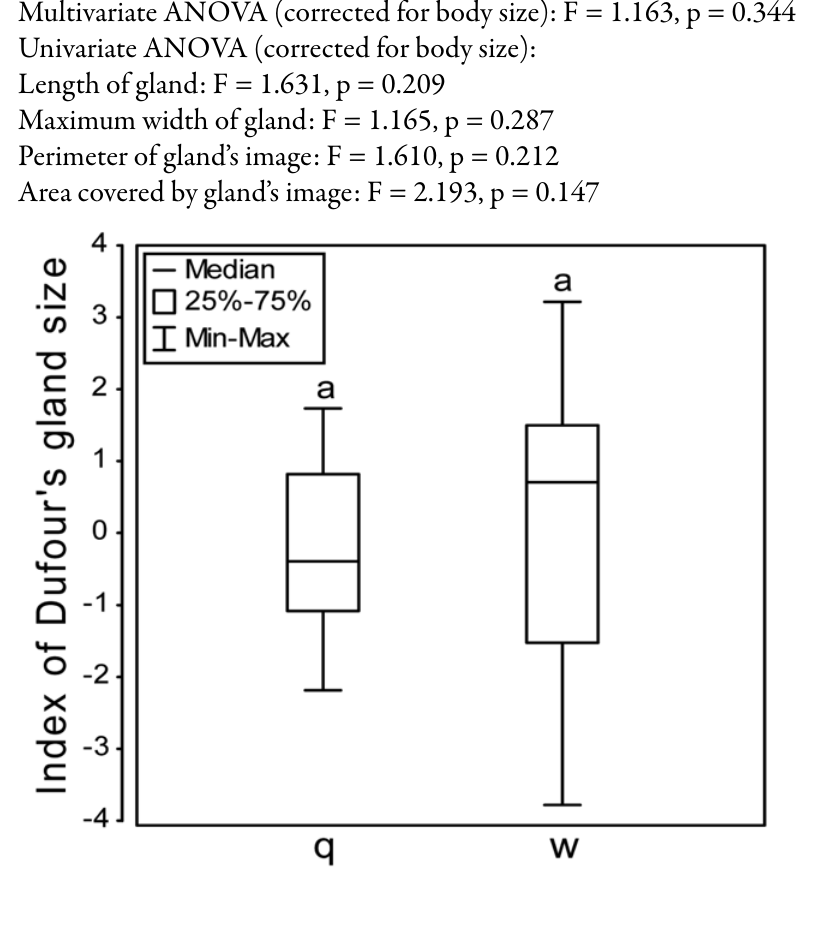
Fig 3: Dufour’s gland size indices of queens (q) and workers (w) of Ropalidia marginata . Distributions carry the same alphabet indicating that they are not significantly different (Mann Whitney U test, p > 0.05, n = 6 queens and 36